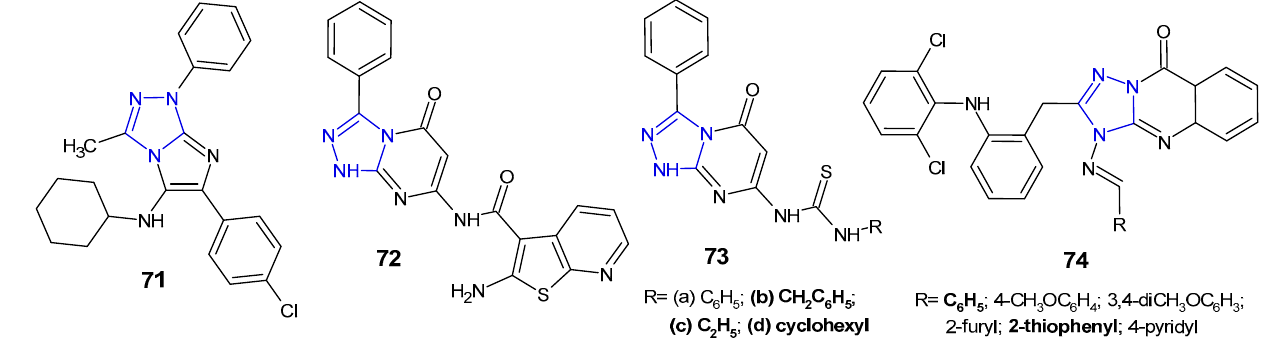
Figure 21. Antibacterial derivatives of 1,2,4-triazolo[3,4- b ][1,3,4]thiadiazoles and 1,2,4-triazolo[3,4- b ][1,3,4]thiadiazines—